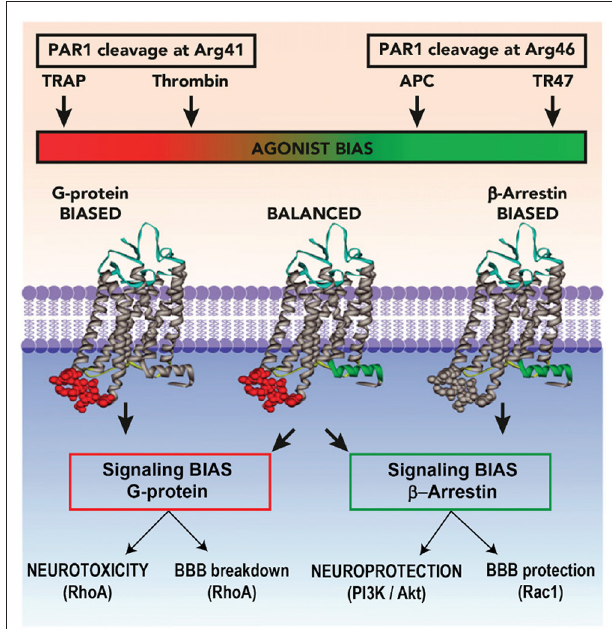
FIGURE 3 | Biased Agonism of PAR-1 by APC. Akt, protein kinase B; APC, activated protein C; BBB, blood–brain barrier; PAR, protease-activated receptor; P13K, phosphoinositide 3-kinase; Rac, Ras-related C3 botulinum toxin substrate; RhoA, ras homolog gene family member A; TRAP,